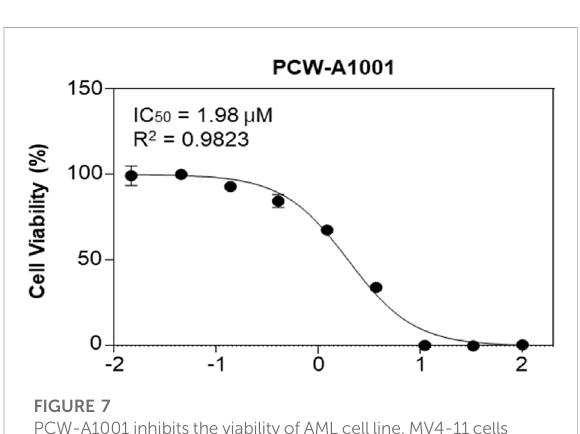
FIGURE 7 PCW-A1001 inhibitstheviability ofAML cellline.MV4-11cells were treated with PCW-A1001 for 72 h, and cell viability was analyzed. The data are presented as the mean ± standard error mean. The dose response curve was generated using OriginPro 2021 (OriginLab, United